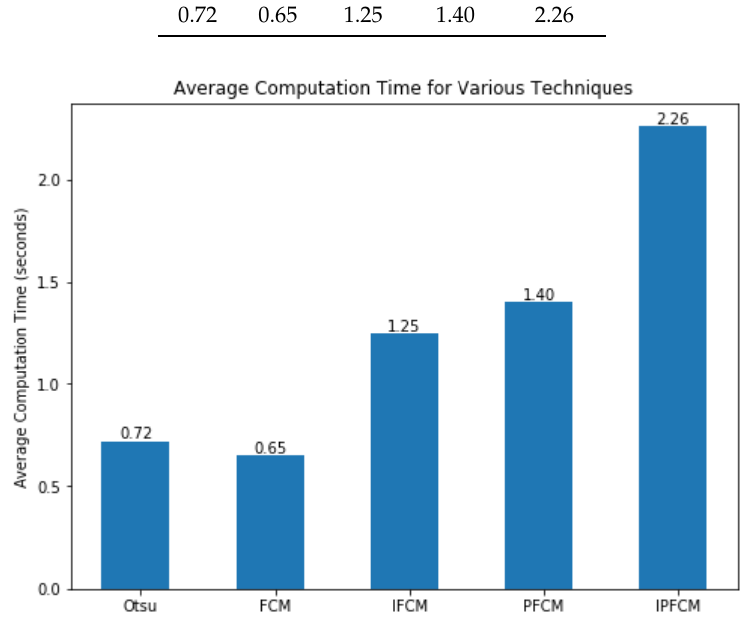
Figure 6. Average computation time for various techniques